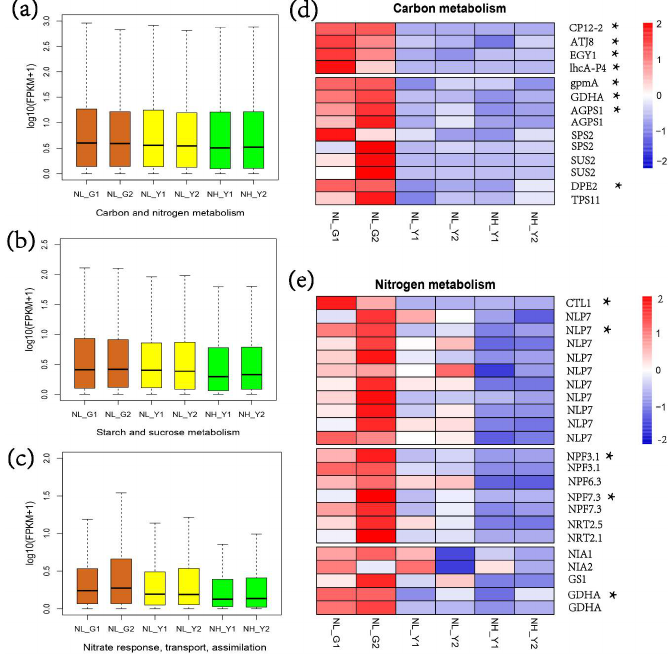
Figure 2. Expressed pattern analysis of genes involved in nitrogen and carbon metabolism in flue-cured tobacco and burley tobacco. ( a ) Primary transcripts correlated with carbon and nitrogen metabolism; ( b ) Starch and sucrose metabolism; ( c ) Nitrate response, transport and assimilation; ( d ) Expression pattern of genes related to carbon metabolism; ( e ) Expression pattern of genes related to nitrogen metabolism. NL_G1: low nitrogen level, HD; NL_G2: low nitrogen level, Z100; NL_Y1: low nitrogen level, TN90; NL_Y2: low nitrogen level, TN86; NH_Y1: high nitrogen level, TN90; NH_Y2: high nitrogen level, TN86. Box-whisker plot represents dispersity of minimum, first quartile, median, third quartile in genes expression level of treatments. Y-axis represents normalized expression level (log 10 (FPKM + 1)). Brown represents genes expression pattern of flue-cured tobacco grown at low nitrogen level. Yellow represents genes expression pattern of burley tobacco grown at low nitrogen level. Green represents genes expression pattern of burley tobacco grown at high nitrogen